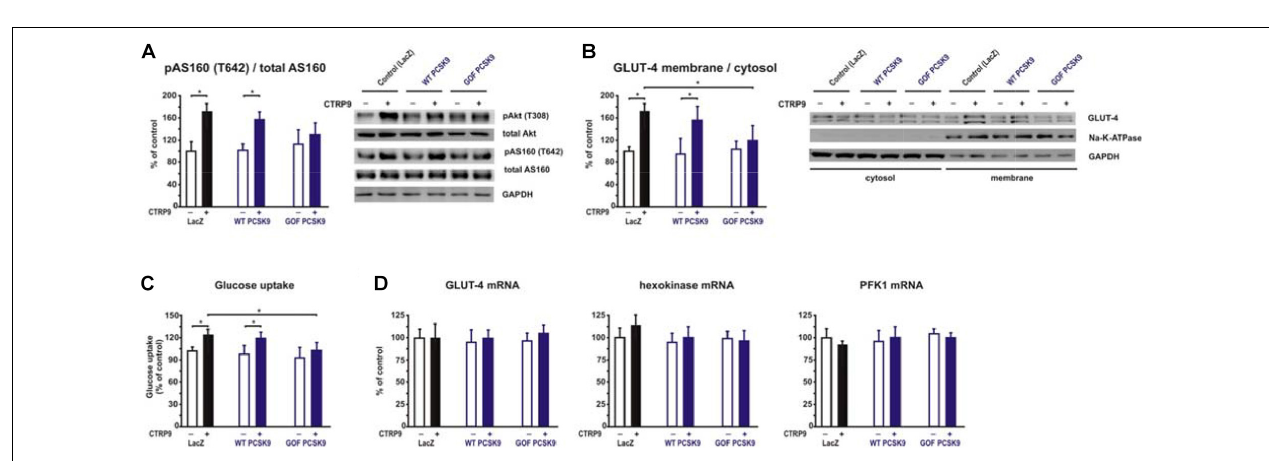
FIGURE 7 | Impact of PCSK9 on CTPR9-induced effects on glucose metabolism. Adult rat cardiomyocytes were incubated in the presence of LacZ-containing supernatant (control), murine wild-type PCSK9 or GOF PCSK9 (each 0.5 µ g/ml) in serum-free medium for 24 h and subsequently treated with CTRP9 (4 µ g/ml) for the indicated times. (A) Phosphorylation of Akt and AS160 was analyzed after 20 min CTRP9 stimulation by Western Blotting. Representative Western blots and densitometry of protein data are shown. Total Akt and total AS160 as well as GAPDH served as a loading control. (B) Translocation of GLUT-4 from the cytosol to the plasma membrane was analyzed after 30 min CTRP9 stimulation. Representative Western blots and densitometry of protein data are shown. Na-K-ATPase served as a marker for membrane fraction and GAPDH as a marker for the cytosol. (C) Glucose uptake was measured after 10 min stimulation with CTRP9. (D) Changes in GLUT-4, hexokinase and PFK1 mRNA expression after 24 h stimulation with CTRP9 were analyzed by Real-time PCR. All data are mean ± SEM, 4 independent experiments, n = 8 per group, * p <